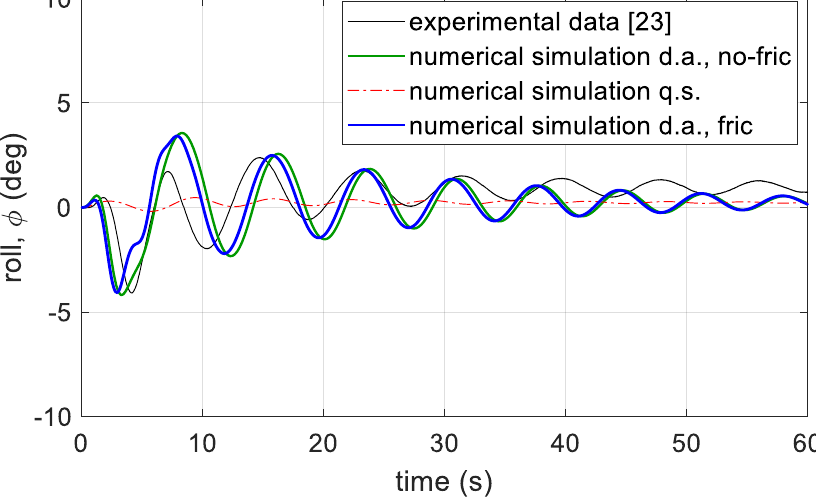
Figure 4. Roll behaviour of the damaged barge during the transient stage of flooding: experimental vs. numerical results.